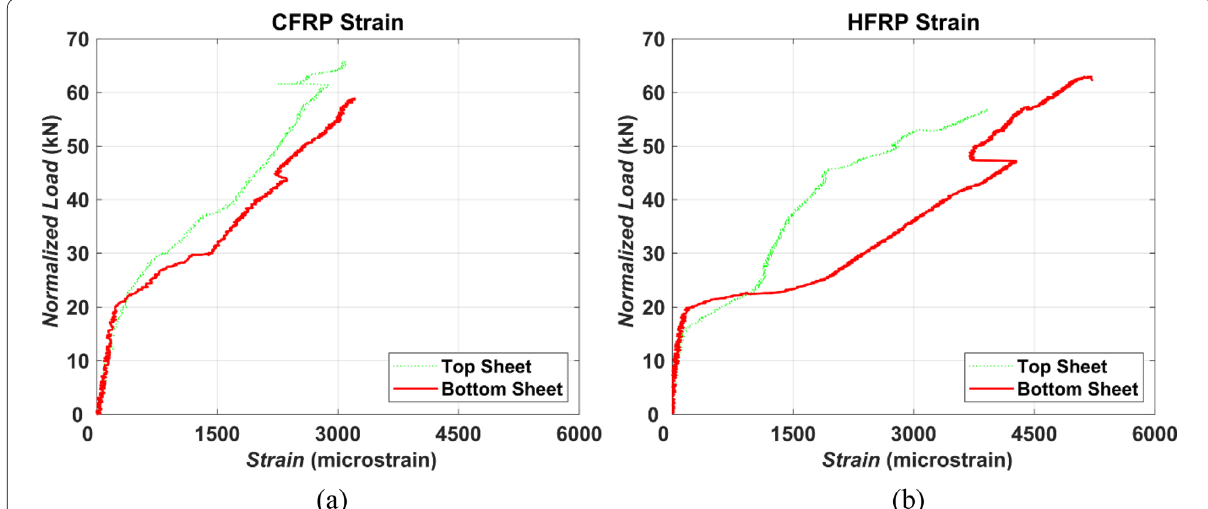
Fig. 14 Typical load versus strain response for a CFRP sheets and b HFRP sheets.